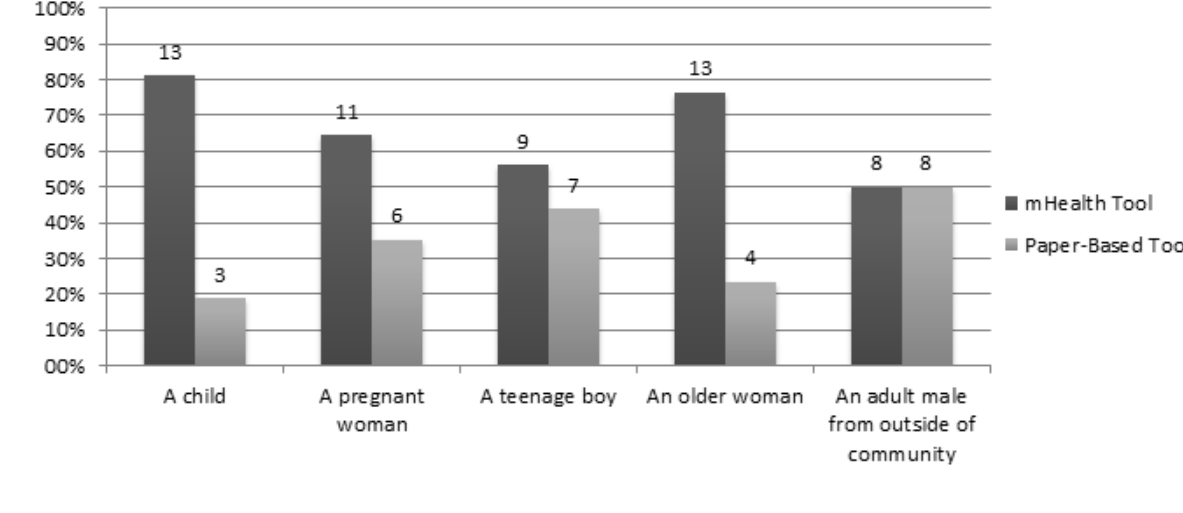
Figure 5. Mean dosing scores for practice test, by tool